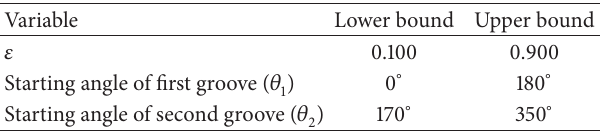
Table 5: Variable bounds for the bearing problem.